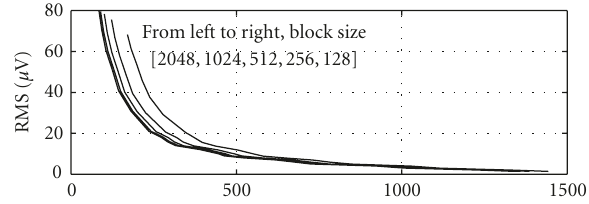
Figure 1: RD curves for di ff erent block lengths obtained for MIT- BIH compression database.